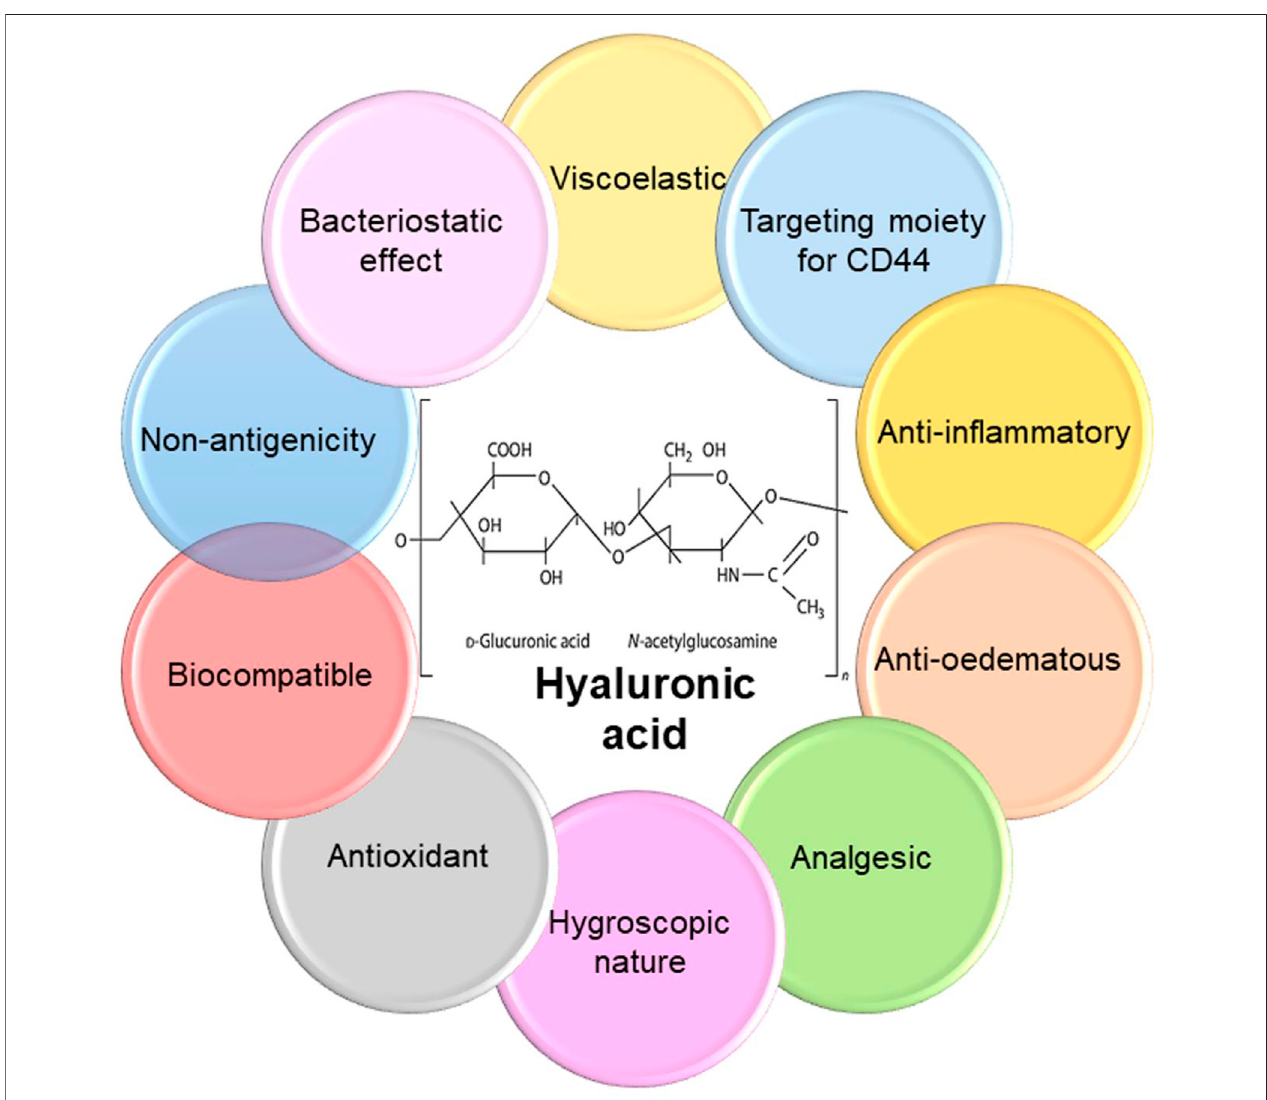
FIGURE1| Chemicalstructureandpropertiesofhyaluronicacid.HAisanaturalbiodegradablelinearpolyanionicmacromolecularmucopolysaccharidecomprised of two repeating saccharide units of glucuronic acid and N-acetylglucosamine linked alternatively by β -1,3- and β -1,4-glycosidic bonds. HA has numerous attractive features that make it suitable option for biomedical